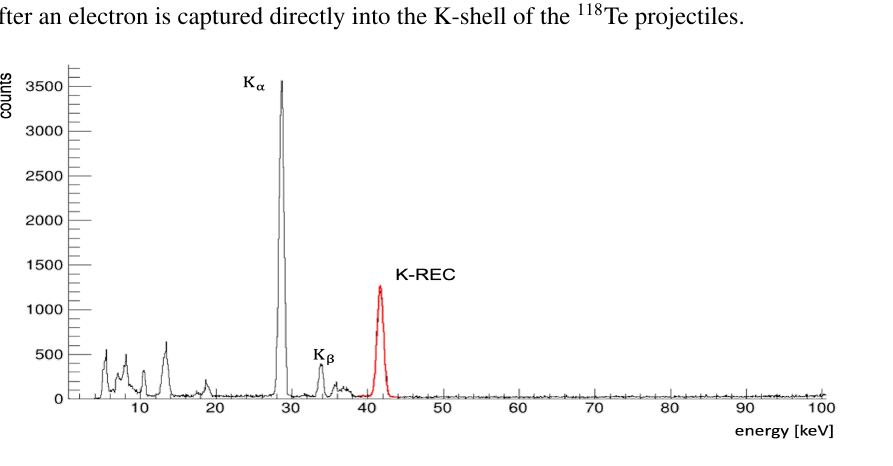
Figure 1. X-ray spectrum recorded by a HPGe detector positioned at an angle of 90 ◦ at the target region. The peak corresponding to the photons emitted after an electron is captured into the K-shell of the 118 Te projectiles is marked in